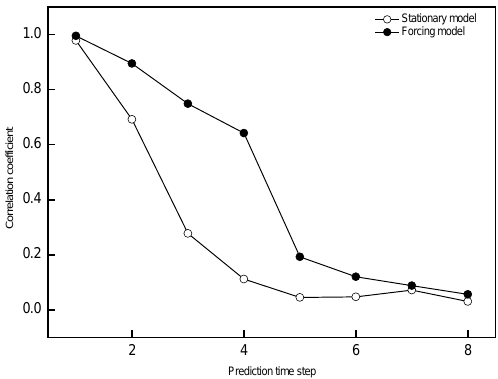
Figure 3. The slowest driving force with different embedding di- mensions for total ozone